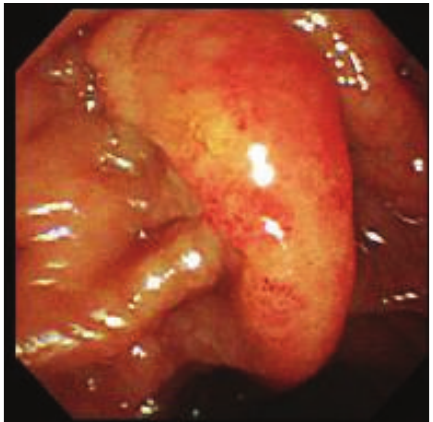
Figure 2: Endoscopic appearance showing the duodenal papilla covered with whitish tiny granules. The tumor of the ampulla of Vater is not